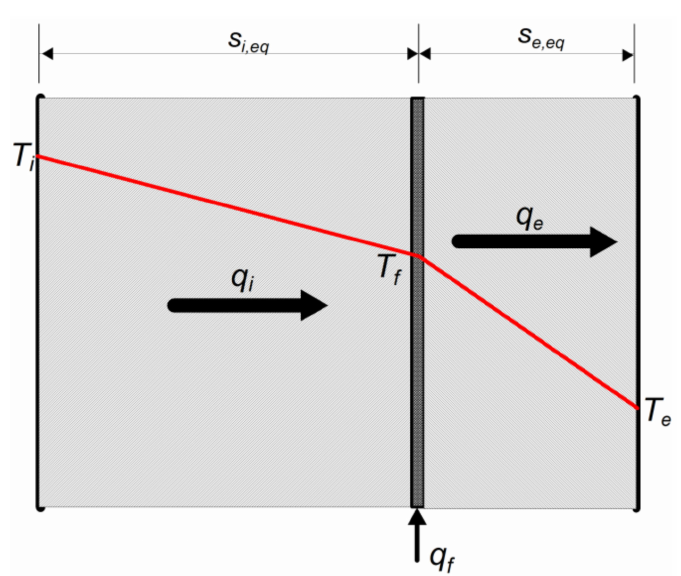
Figure 1. Envelope with an active insulation